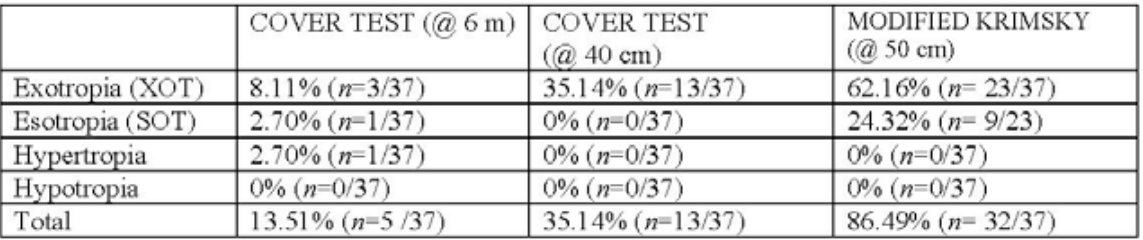
Table 1: Prevalence of the strabismus detected, with the use of different tests in a sample of schizophrenic subjects